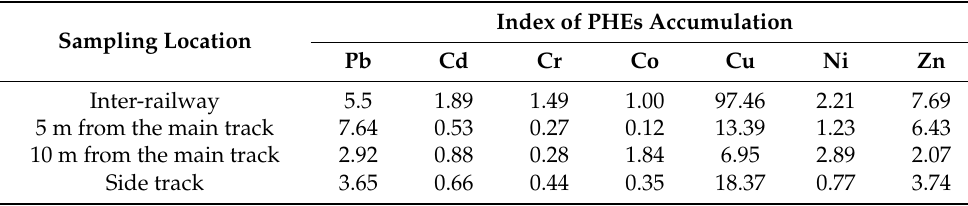
Table 2. Contamination degree based on accumulation index